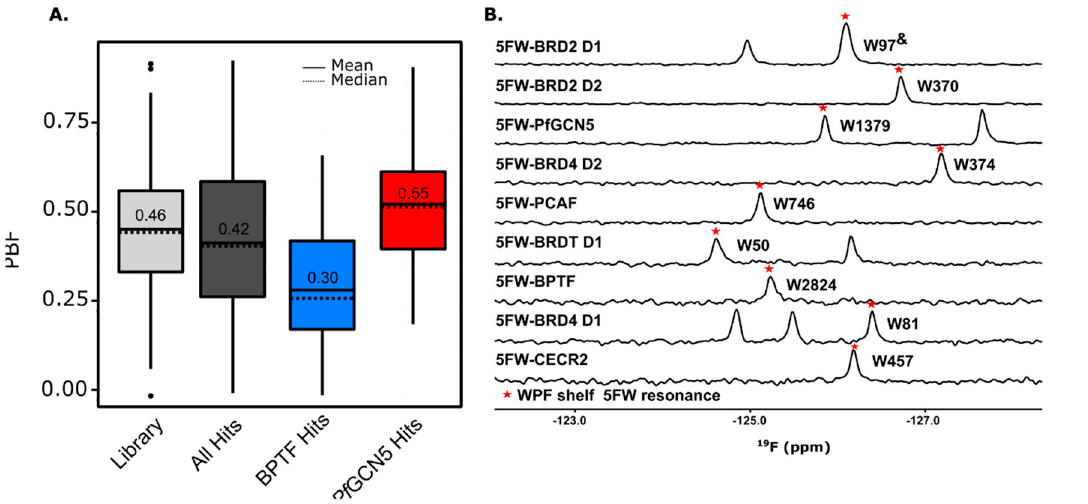
Figure 3. ( A ) Boxplot of the PBF of the library, total hits, and hits selective for BPTF and Pf GCN5. ( B ) PrOF NMR overlay of various 5FW-labeled bromodomains. The W in the WPF shelf near the binding site is denoted with a red star and label. & The 5FW resonances have not been assigned but this W is the one that shows the largest response with known ligands [55]. Also see Figure S9.